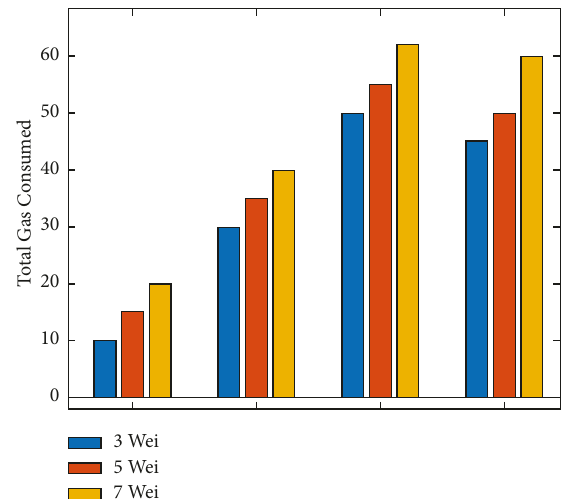
Figure 10: The amount of gas used by the remote facility, smart contracts, and consumers